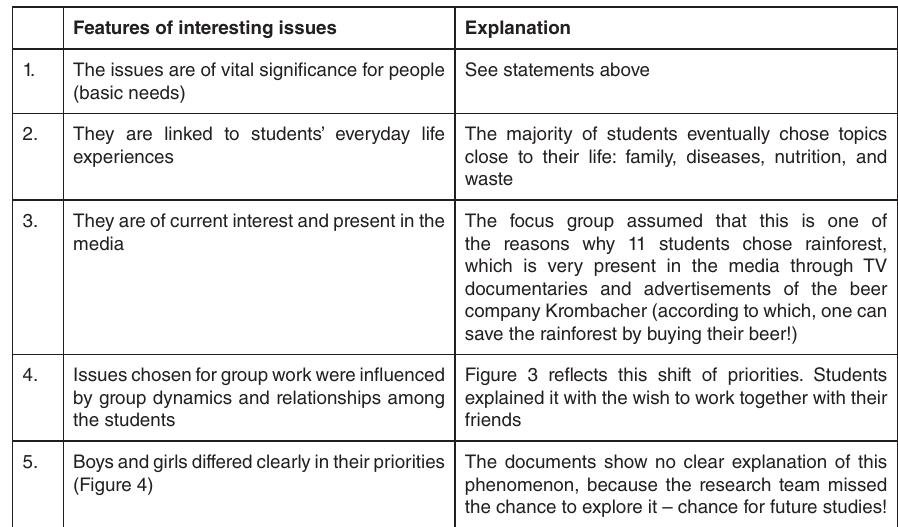
Table 2: Features of interesting